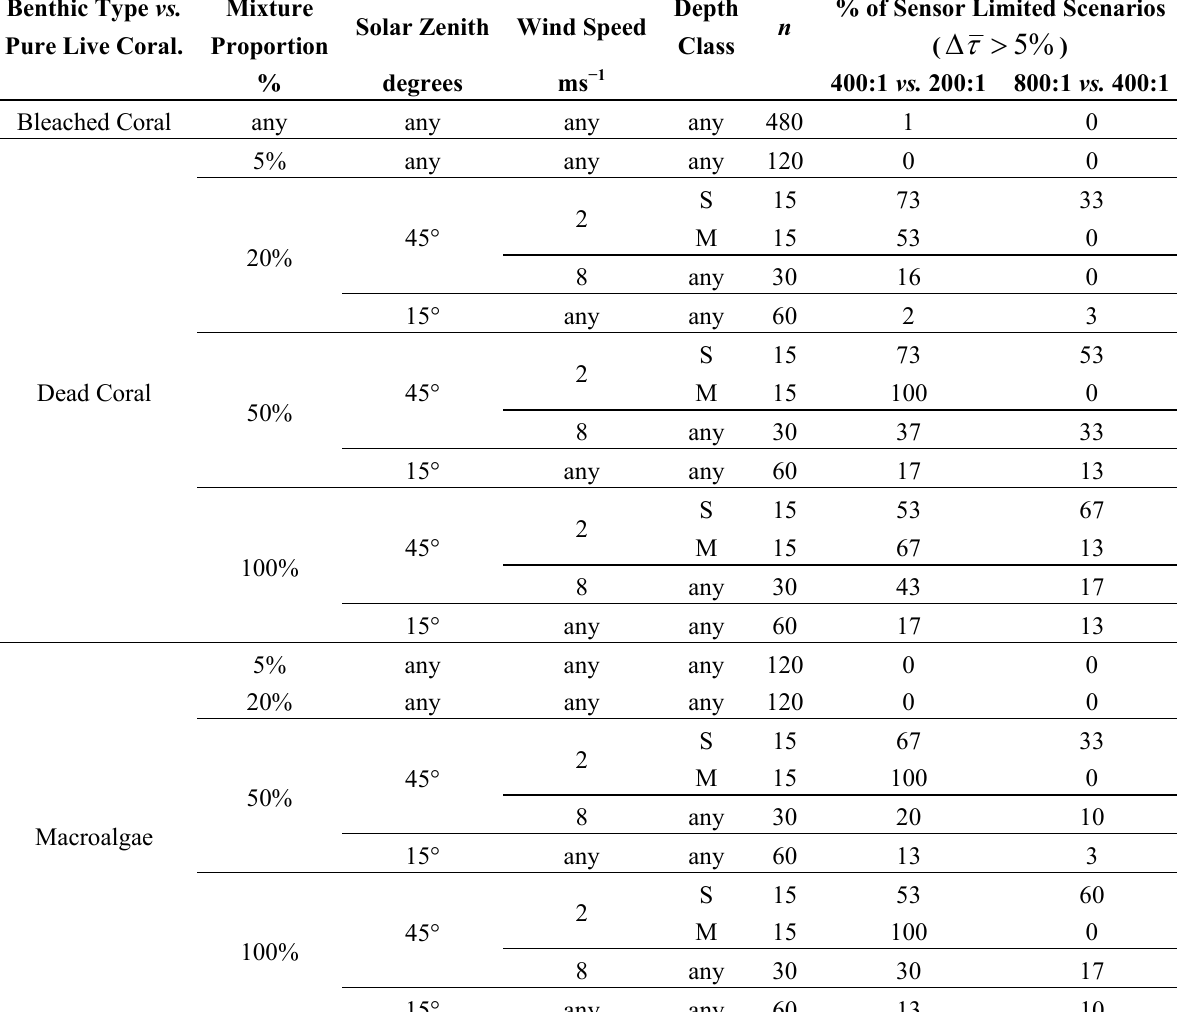
Table 5. Distribution of sensor limited scenarios in the sensitivity analysis as a function of benthic type to be discriminated from Live Coral, proportion of that type in Live Coral, sun zenith angle, wind speed and depth class: S = single-depth classes: 0.5 m, 5 m, 20 m; M = multiple-depth classes: Shallow, Shallow-Mid, Shallow-Deep. Each row represents n class combinations from the analysis and rows are hierarchically structured to focus on class combinations where sensor limitation occurred. Sensor limitation is presented as the percentage of class combination scenarios under which a doubling of sensor SNR produces in increase in benthic class separability,  , of greater than five percentage points. Benthic Type vs. Mixture Wind Speed Pure Live Coral. ms − 1 400:1 vs. 200:1 800:1 vs.